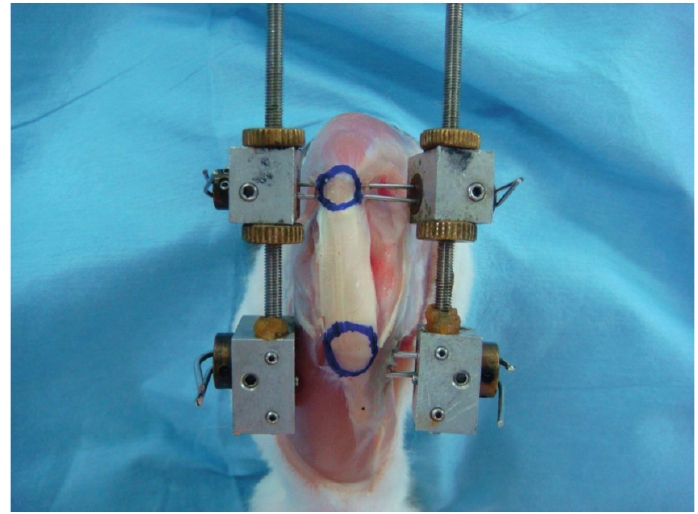
Figure 8. Position of the external fixation device in the right knee of a rabbit. Two stainless steel wires were inserted into the patella perpendicular to the patella-tendon axis, and another two stainless steel wires into the tibial tubercle perpendicular to the tibial axis. The external fixation device was positioned along both sides of the right knee. The upper blue circle indicates the patella; the lower blue circle indicates the tibial